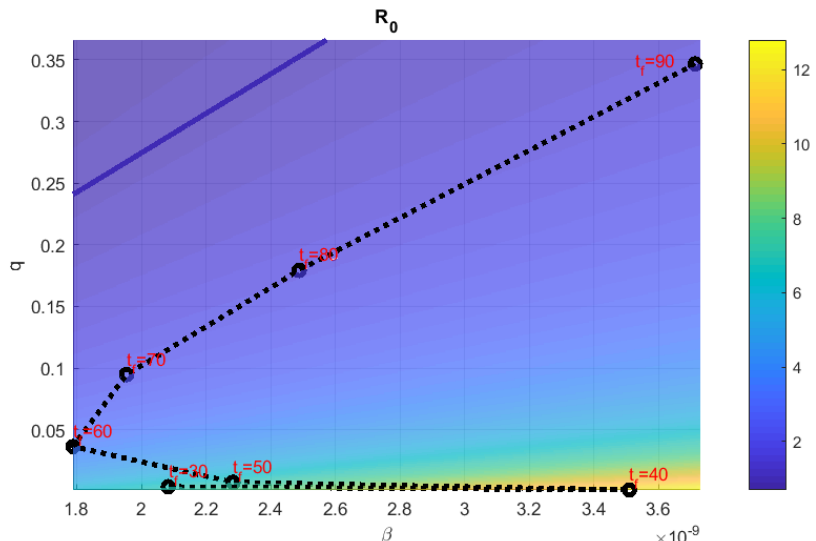
Figure 5. Sensitivity of the Reproduction number to β and q . The dotted line shows the time evolution of R 0 in β − q space in the case of